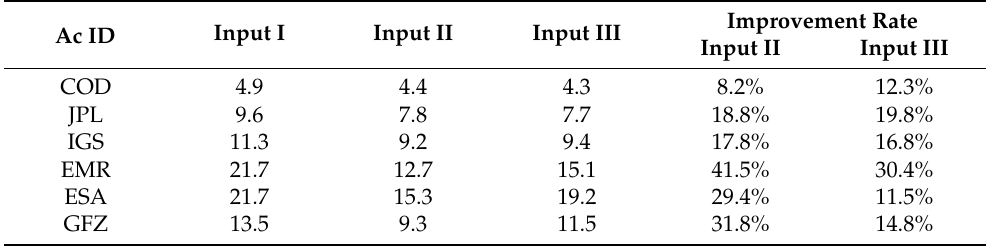
Table 4. Statistic differences in kinematic PPP 1D-RMS accuracy between boundary and non- boundary (unit: